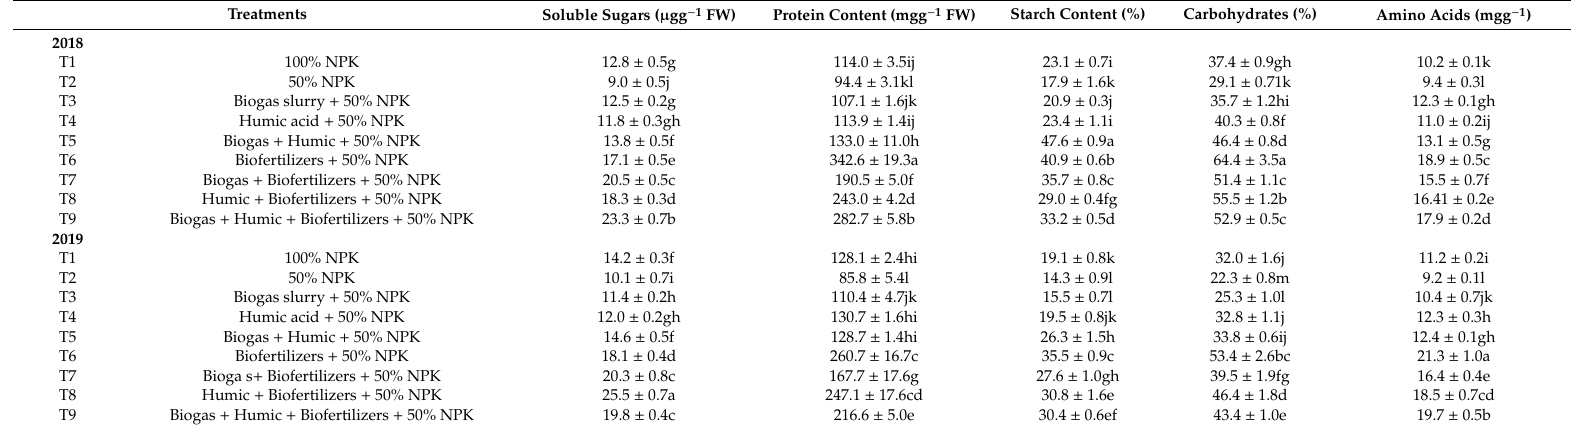
Table 5. Grain quality of maize treated with organic and biofertilizers alone or in combination.